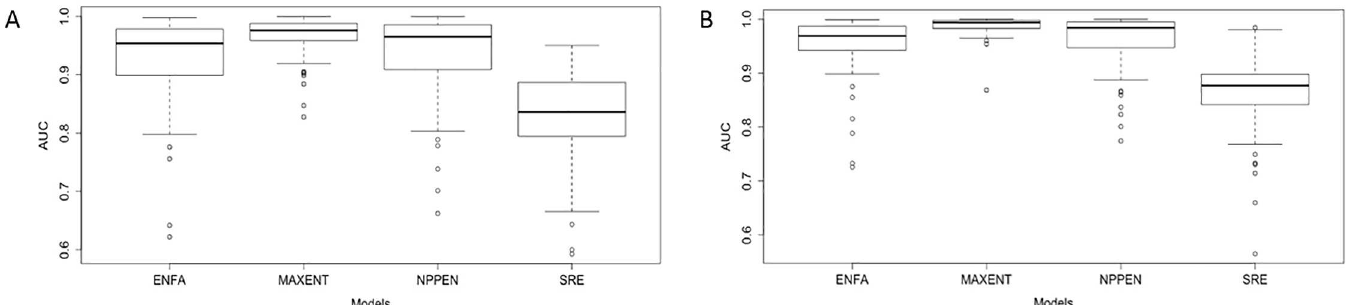
Fig 2. Prediction evaluation of each SDM used in the analysis. (A) AUC for the habitat suitability index (HSI) for natural occurrences of farmed species across SDM; (B) AUC for mariculture location HSI across SDMs. The horizontal lines represent median values. The upper and lower boundaries of the box represent the upper and lower quartiles of the data. ENFA- Ecological Niche Factor Analysis, MAXENT- Maximum Entropy, NPPEN- Non- Parametric Probabilistic Ecological Niche and SRE- Surface Range Envelope.